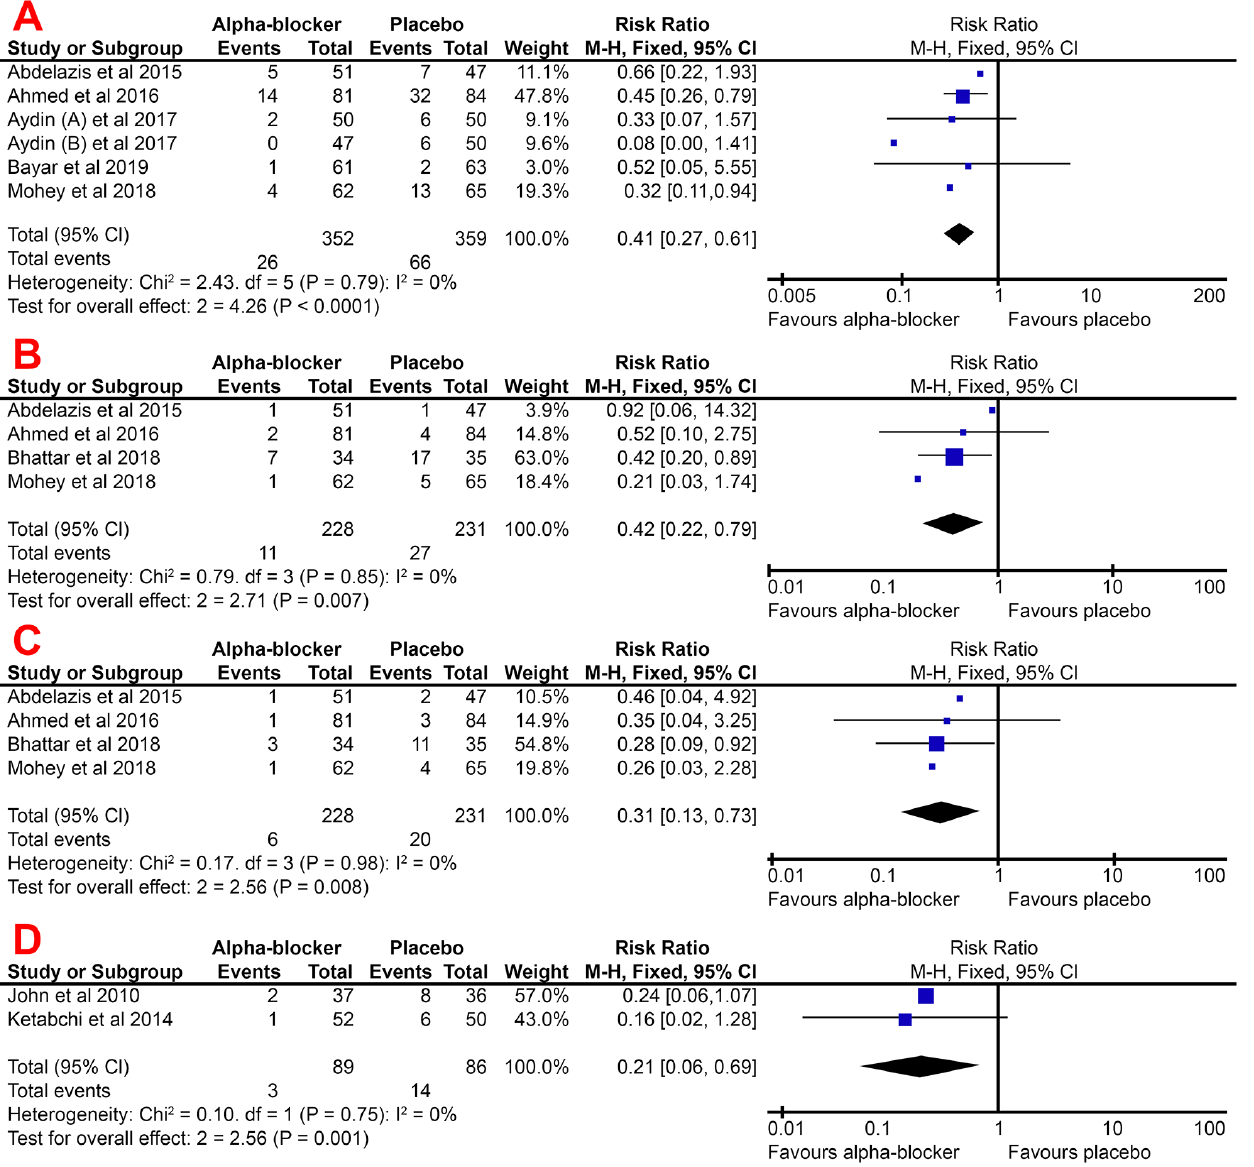
This systematic review and meta-analysis have several